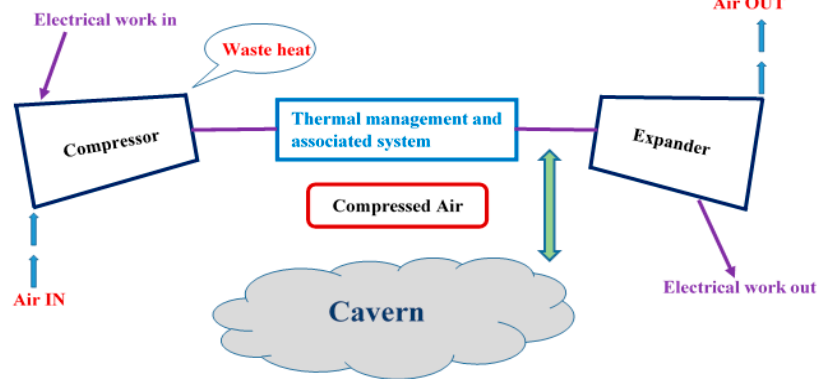
Figure 3. Compressed air energy storage system schematic.